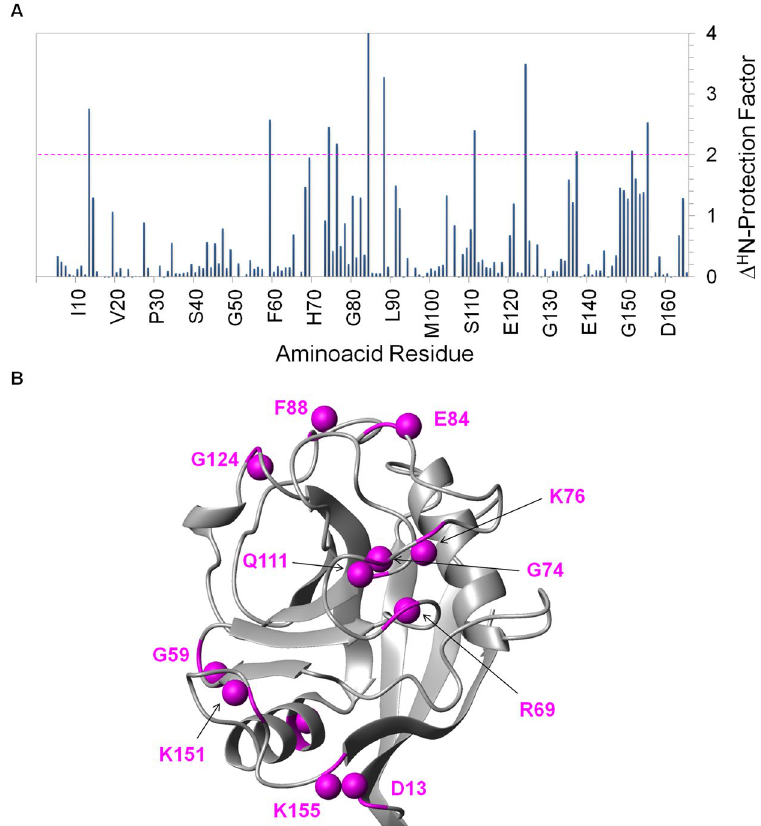
Figure 3. Identification of the AIF(370-394) interaction surface on CypA by NMR-H/D exchange studies. ( A ) Bar graphs of the difference of the H N -PFs between the free and bound protein ( Δ H N -PF) as a function of the amino acid residue. The broken line traced at Δ H N -PF = 2 is used as threshold to identify the protected amides upon binding. ( B ) Amide hydrogens of residues showing Δ H N -PFs higher than 2 were represented as balls in magenta onto the ribbon drawing of the representative conformer of the NMR structure of CypA (PDB ID 1OCA) 28 . ( C ) Comparison of the Δ H N -PF and CSP patterns by mapping on the amino acid sequence of CypA. Residues affected upon AIF(370-394) binding both by the H/D exchange and by the CSP studies are shown in blue; residues identified by CSP or H/D exchange studies are shown in red and in magenta,